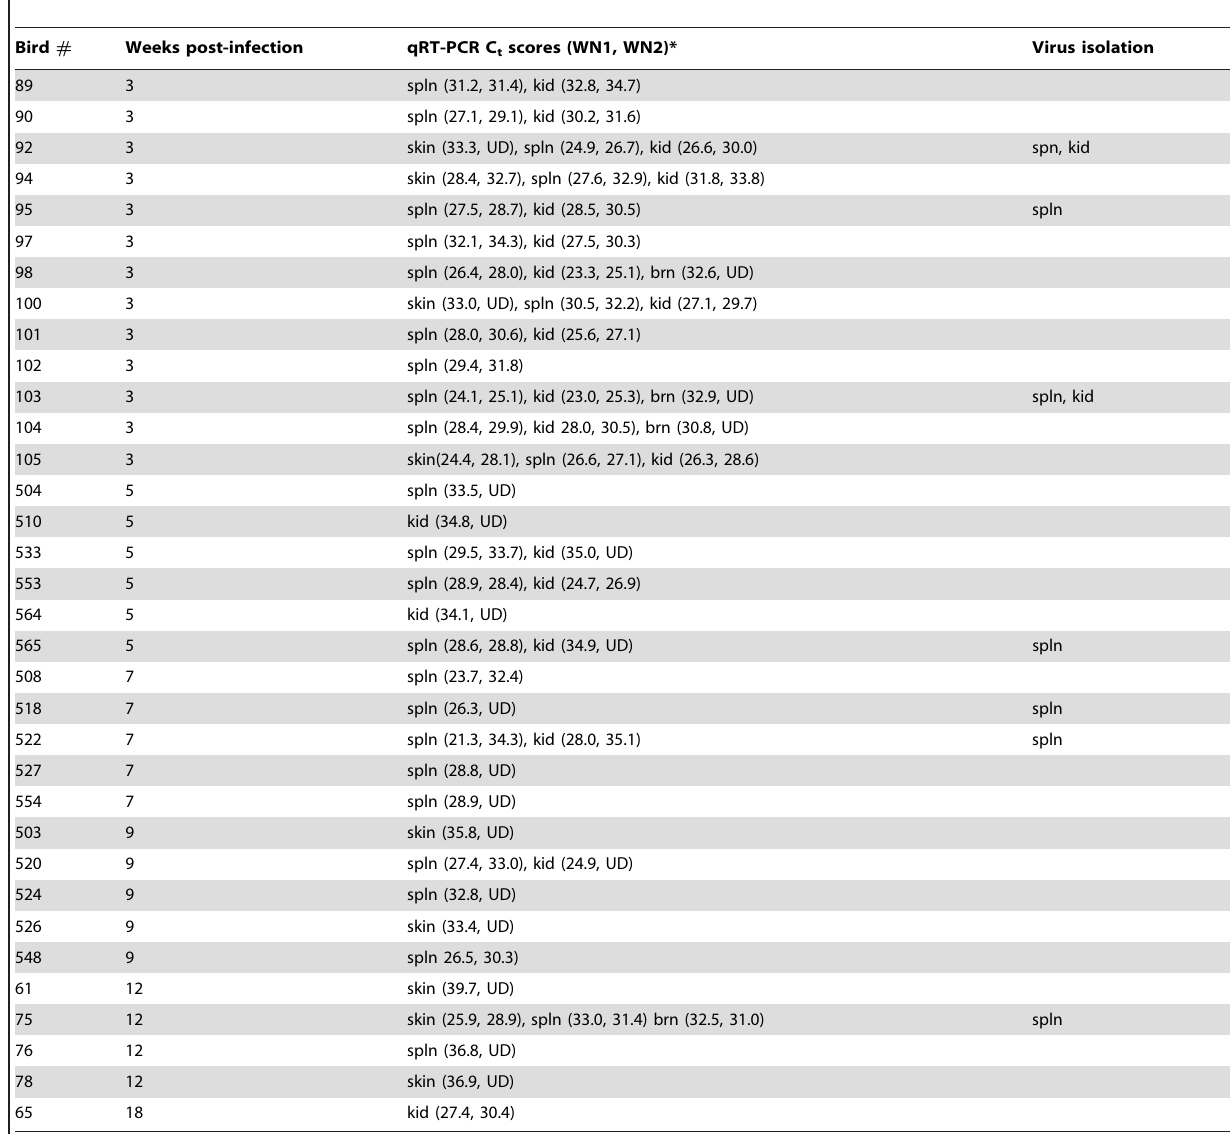
Table 1. House Sparrows ( Passer domesticus ) tissues persistently infected with West Nile virus (WNV) at necropsy.